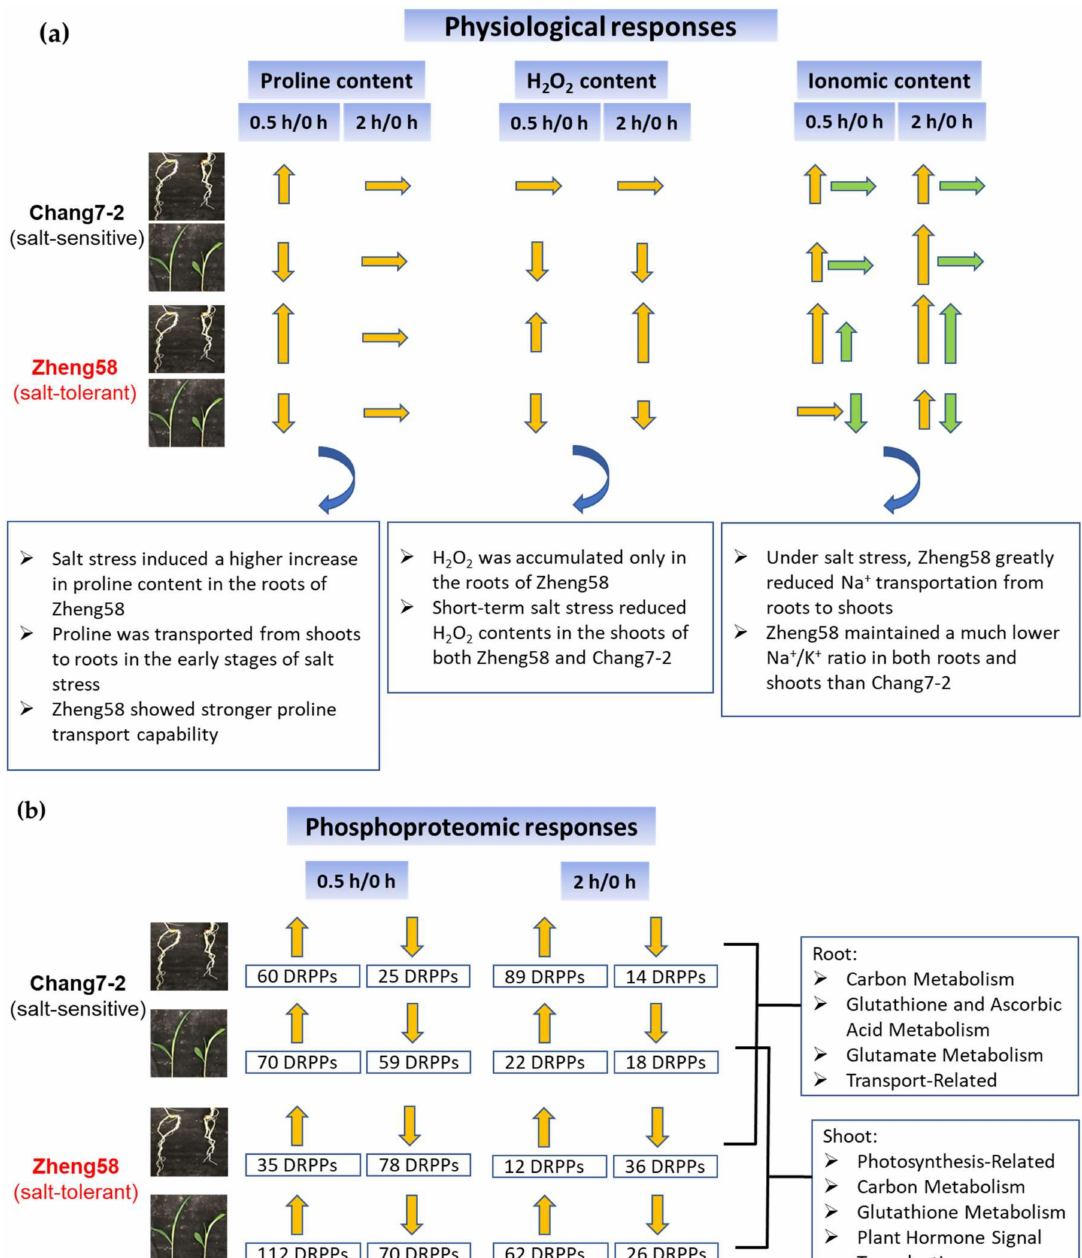
Figure 8. A summary of di ff erences in physiology ( a ) and phosphoproteomics ( b ) in response to salinity stress in roots and shoots of Chang7-2 and Zheng58. The up arrows indicate upregulation and the down arrows indicate downregulation; The lengths of the arrows indicate the degree of changes; In the ionomic content section, the yellow arrows represent Na + and the green arrows indicate K +